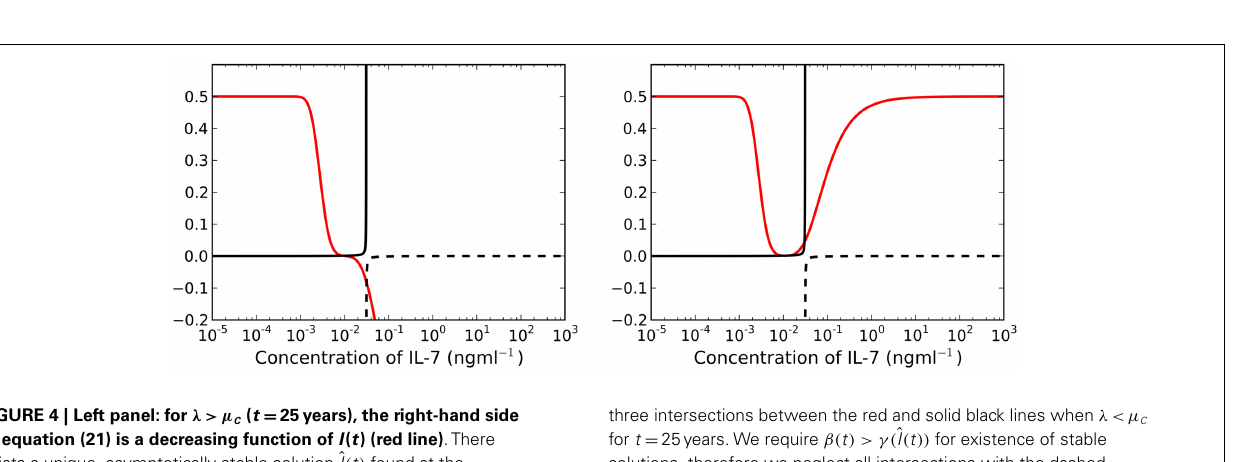
FIGURE 4 | Left panel: for λ>µ C ( t = 25years), the right-hand side of equation (21) is a decreasing function of I ( t ) (red line) .There exists a unique, asymptotically stable solution ˆ I ( t ) found at the intersection of the solid black and red lines. Right panel: there exist